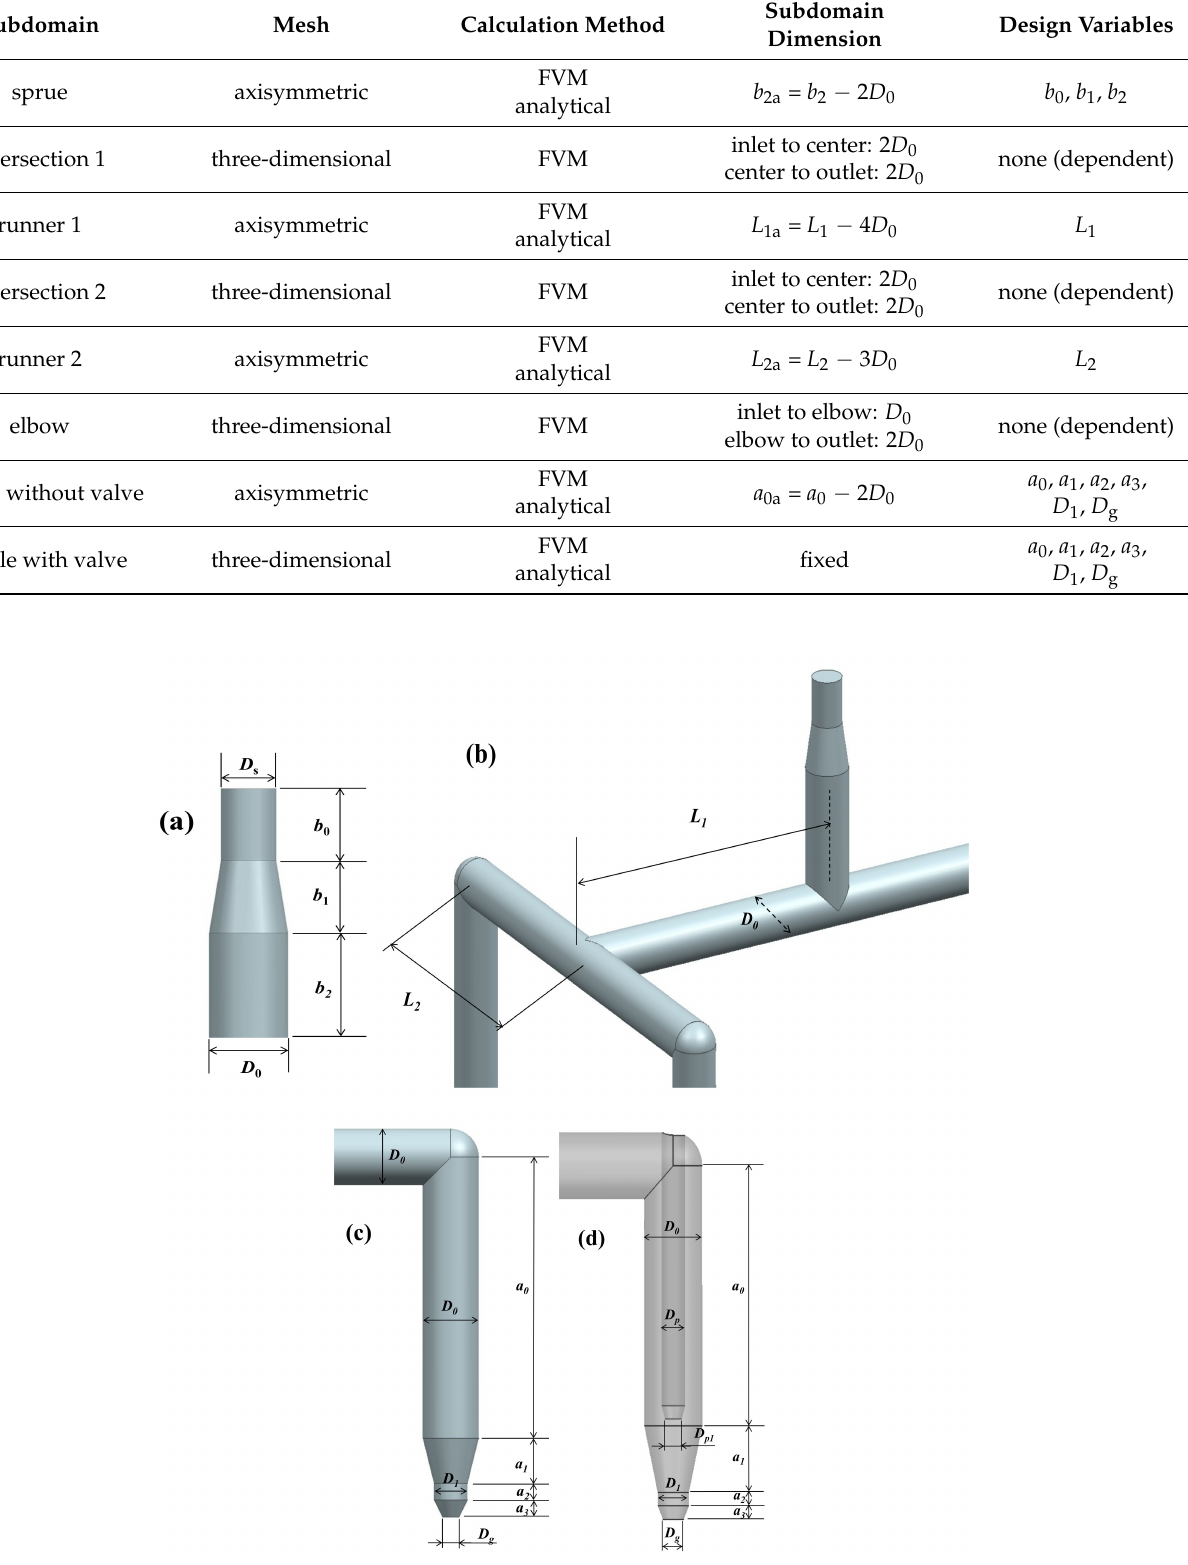
Figure 6. Major design variables: ( a ) sprue; ( b ) runners; ( c ) nozzle without valve; and ( d ) nozzle with